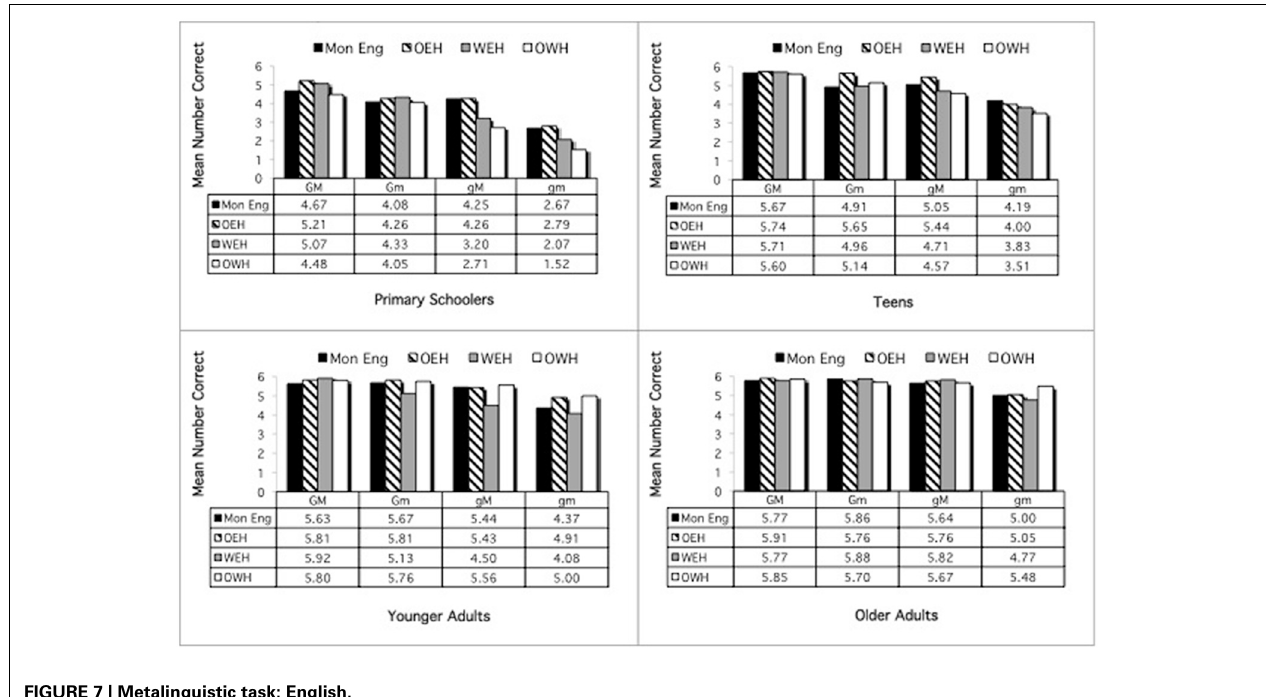
FIGURE 7 | Metalinguistic task: English.